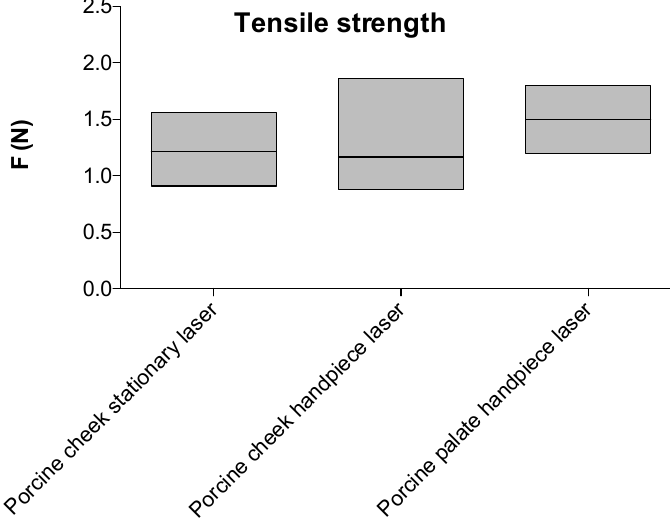
Figure 2. Tensile strength of the collagen membrane tested on porcine cheek and a porcine palate using a stationary laser and a laser that was equipped with a handpiece. The central lines represent means, the boxes represent minimum and maximum values.